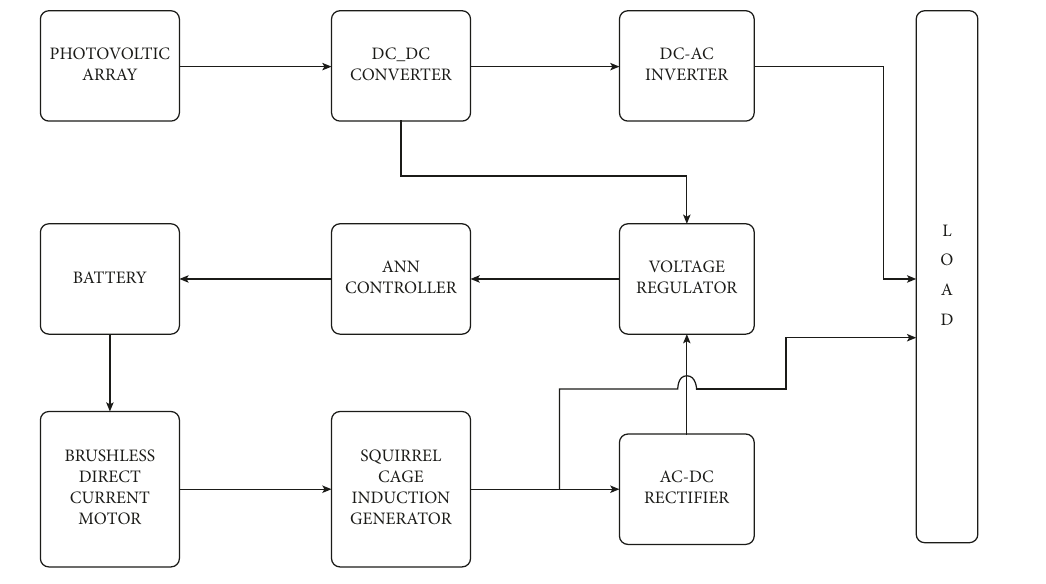
Figure 1: Block diagram for the proposed system.